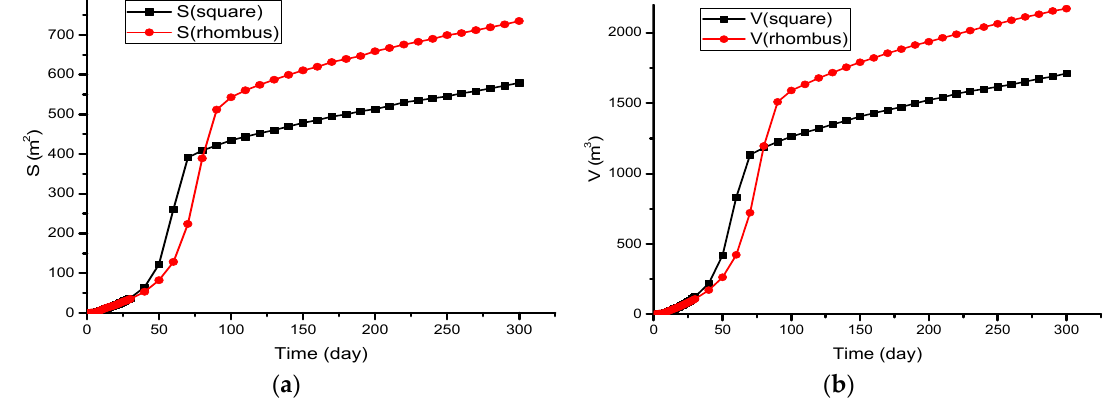
Figure 10. ( a ) Outburst elimination area and ( b ) volume before and after optimization.